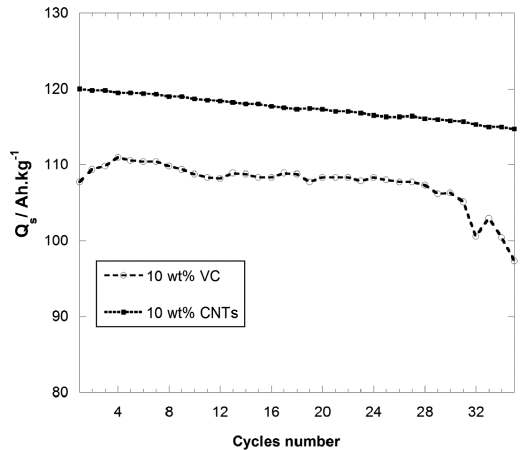
Figure 16. Cycling performance of nanocomposites electrodes at C/10 rate: LMO/10 wt% VC (10 wt%), LMO/CNTs (10 wt%), LMO/CNTs (2 wt%)/Carbon Vulcan (8